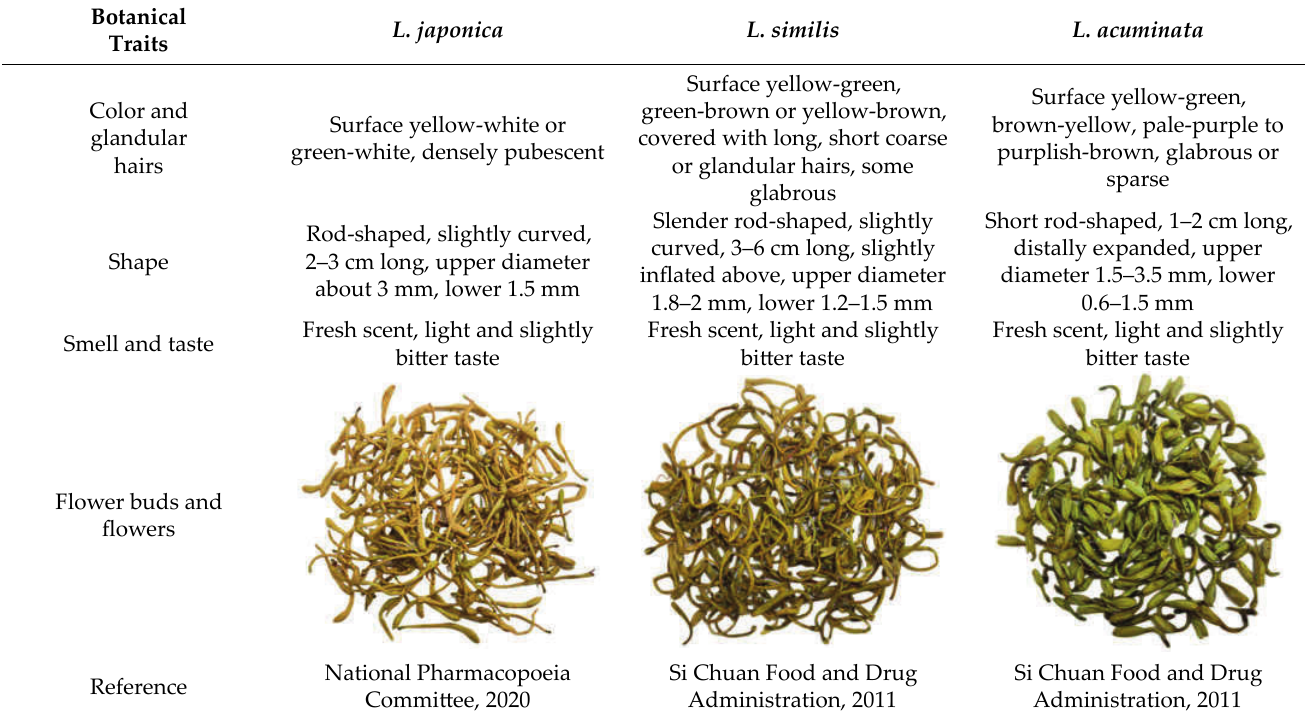
Table 2. The comparison of Botanical traits of Lonicerae japonicae flos and Lonicerae similis flos.